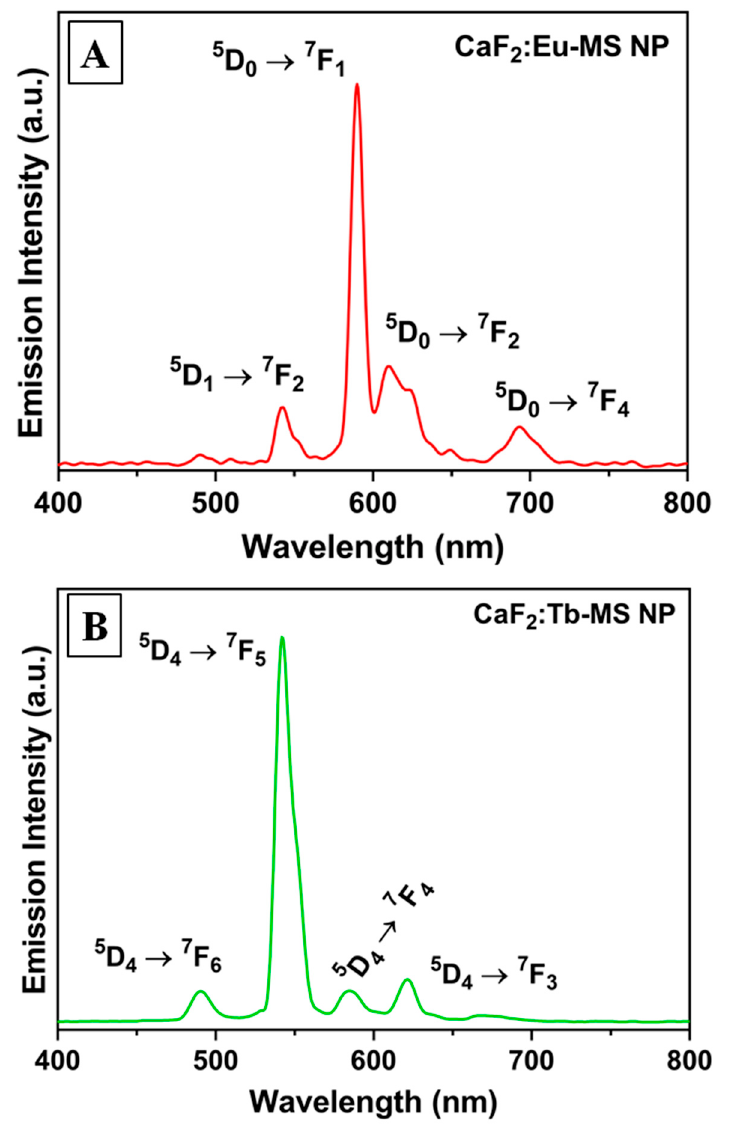
Figure 4. Radioluminescence emission spectra of ( A ) CaF 2 :Eu-MS NPs and ( B ) CaF 2 :Tb-MS NPs.